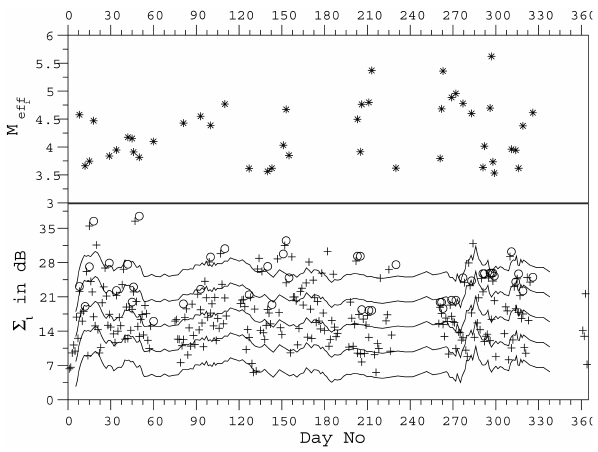
Fig. 1. In the upper panel we plot the effective magnitude ( > 3.5) of the seismic event on each day. The lower panel shows the vari- ation of 6 i (marked with a “+” sign), the standard deviation of the nighttime fluctuation of signal amplitude on i -th day, as a function of day number i for the year 2007. The curve in the center is the mean drawn through these 6 i and the curves above and below are for ± σ , ± 2 σ variations around the mean. The circles represent the > 3 . 5 on each day earthquakes having effective magnitudes M eff i (shifted suitably) just to show the possible association of the earth- quake with an